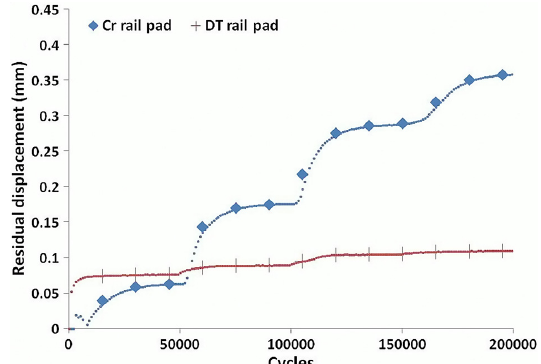
Fig. 8. Evolution of the residual displacement of the DT and CR rail pad